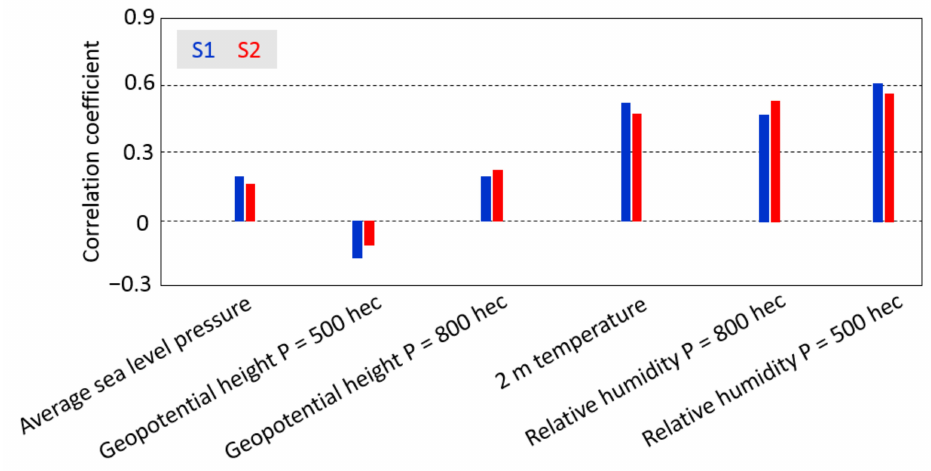
Figure 9. Correlation coefficient between the meteorological parameters and precipitation for the SDSM mode at the two selected